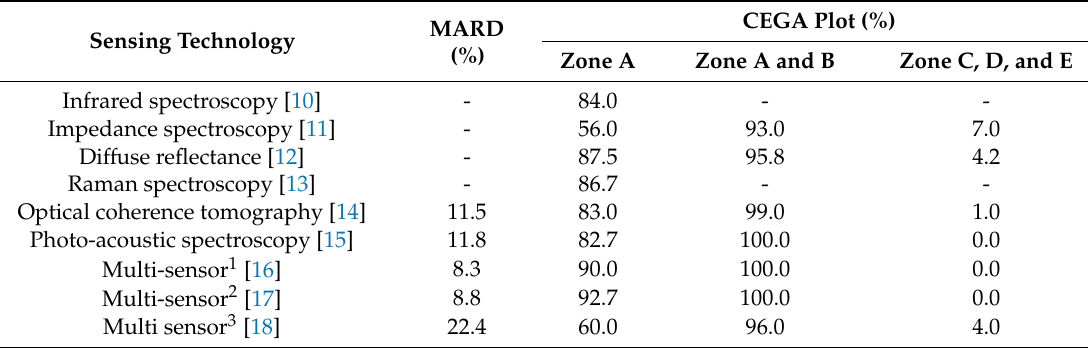
Table 3. Comparison of non-invasive sensor technologies with their